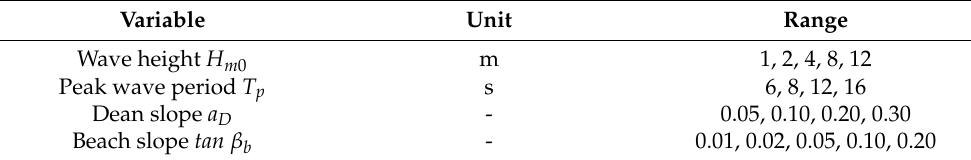
Table 1. Offshore wave and cross-shore geometry parameters.